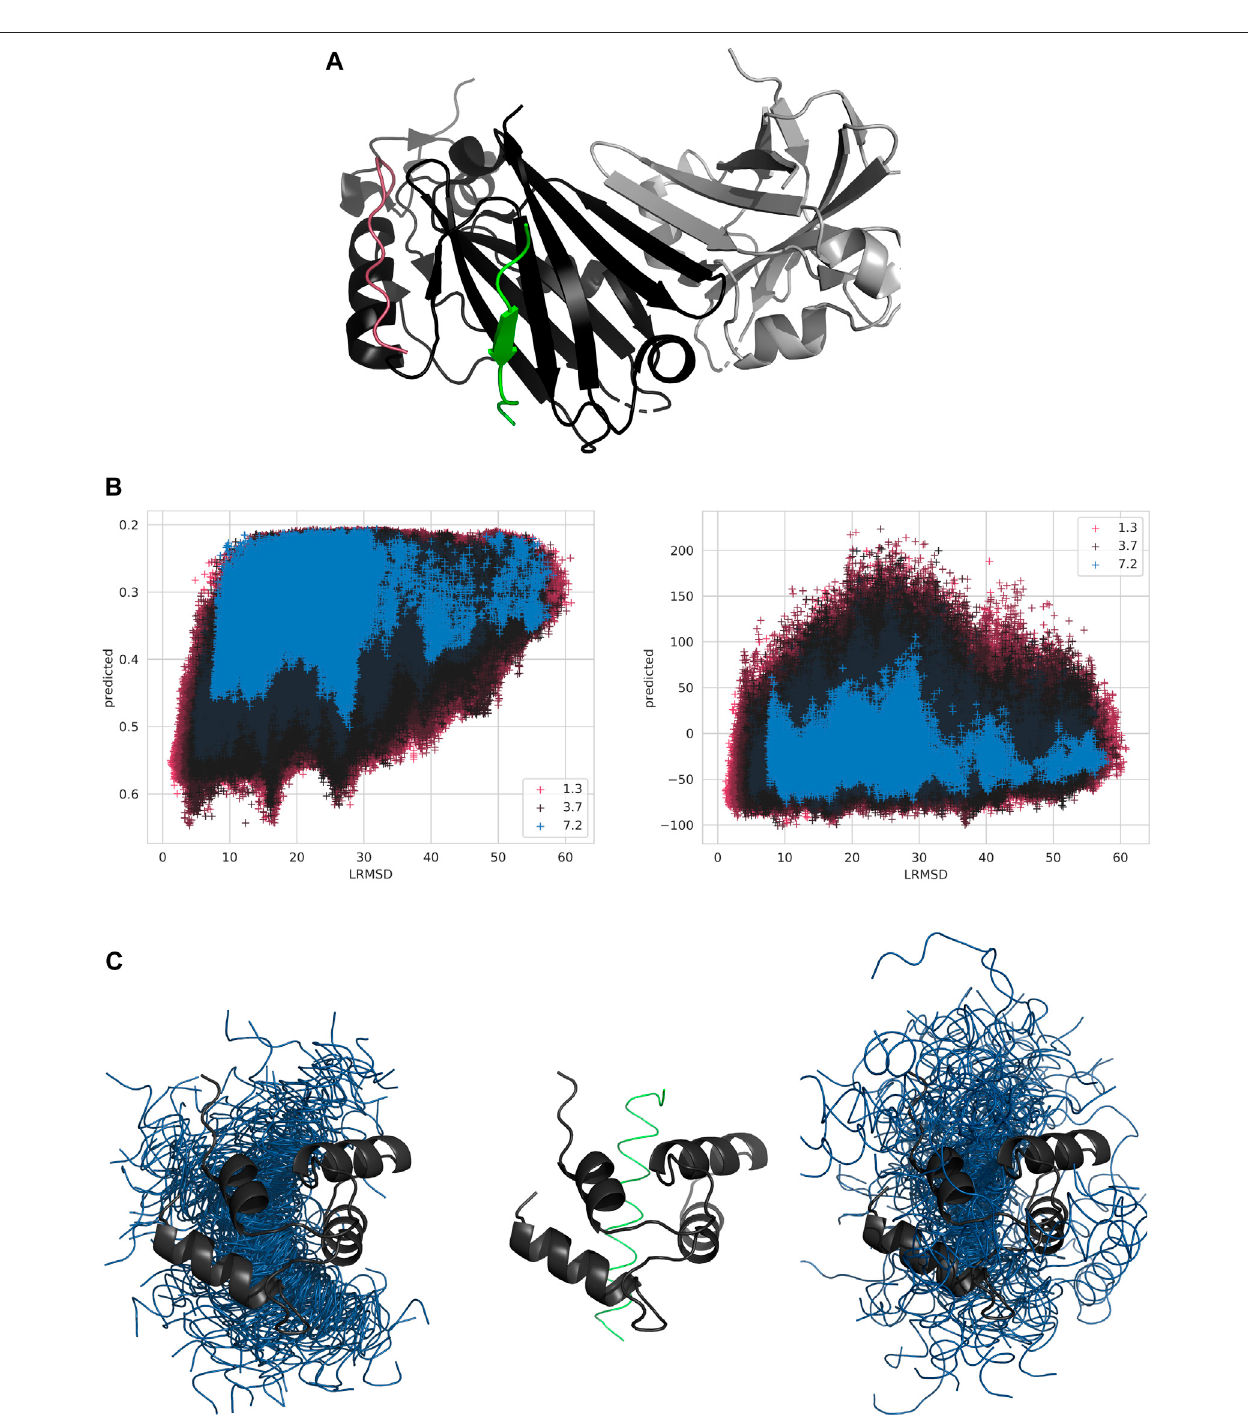
FIGURE6|(A) Siah1incomplexwithasyntheticpeptide(PDB-ID4i7b).Siah1isshowninblack,thenativeconformationofthepeptideisshowningreen,theother chain in the asymmetric unit is shown in gray, and an example peptide conformation maximizing interaction in the alternate groove is shown in pink. (B) Scatterplot of InterPepRankpredictedscore (left) andZrankpredictedscore (right) versusLRMSDforalldecoysof4i7bchainsA(receptor)andB(peptide).Eachdecoyiscoloredby the backbone RMSD of the peptide to its native conformation if superimposed. (C) C-terminal domain of Akazara scallop troponin C with fragment of troponin I (PDB-ID3izt).TroponinCshowninblack,nativeconformationofthepeptideshowningreen,anddecoysgeneratedbydockingshowninblue.Leftimageshowsthe100 top ranked decoys by InterPepRank and the right image shows the 100 top ranked decoys by Zrank.